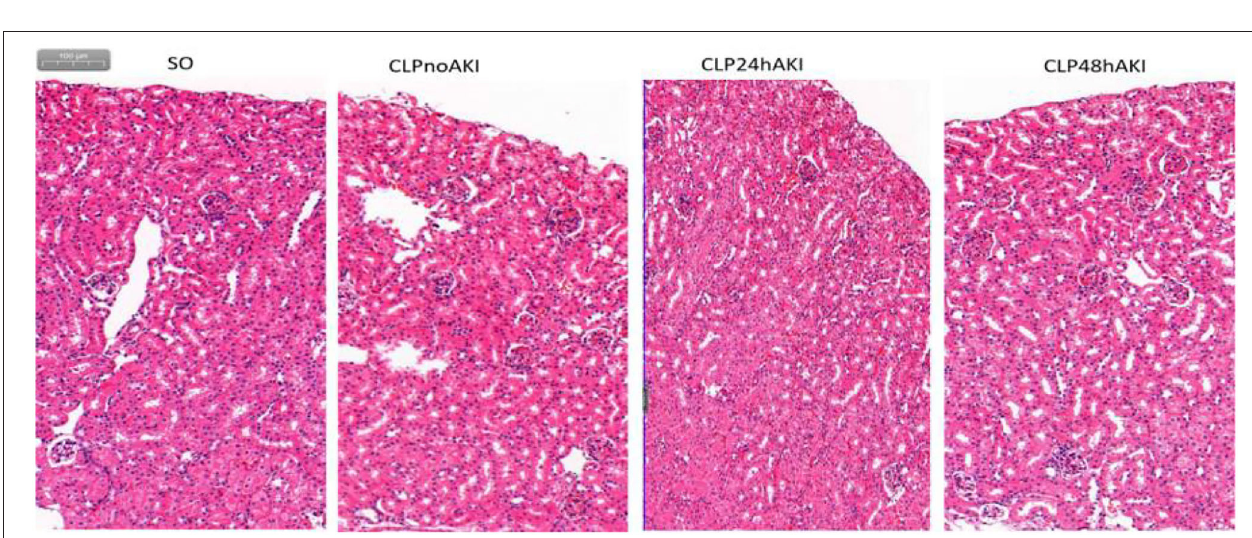
FIGURE 1 | CLP sepsis induces early acute kidney injury. (A) Scr had significant increases in CLP24hAKI ( n = 4) and CLP48hAKI ( n = 3) mice compared with CLPnoAKI( n = 3) mice (CLP24hAKI vs. SO, 0.19 ± 0.05 vs. 0.12 ± 0.06, p = 0.011; CLP48hAKI vs. SO, 0.21 ± 0.05 vs. 0.12 ± 0.06, p = 0.003). (B) Serum BUN had significant increases in CLPnoAKI compared with SO ( n = 3) and CLP48hAKI mice(CLPnoAKI vs. SO, 29.1 ± 9.3 vs. 18.9 ± 1.2, p = 0.039; CLPnoAKI vs. CLP48hAKI,29.1 ± 9.3 vs. 16.2 ± 7.8, p = 0.013); there are no differences among NC ( n = 3), SO, CLP24hAKI and CLP48hAKImice. NC, Normal control C57 mice; SO, Sham Operation; CLPnoAKI, CLP without AKI; CLP24hAKI, AKI after CLP 24h; CLP48hAKIAKI after CLP 48h. *, p < 0.05; **, p < 0.01; NS, p > 0.05.